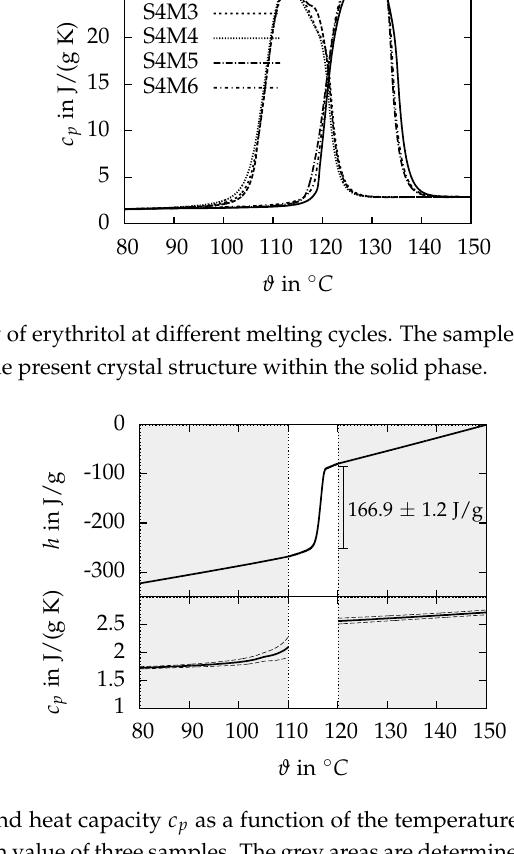
Figure 6: Enthalpy h and heat capacity c p as a function of the temperature ϑ for MCHH. The upper graph presents the mean value of three samples. The grey areas are determined with the c p -comparative method and the melting peak with a sensitivity calibration. The dashed lines represent the standard deviation.